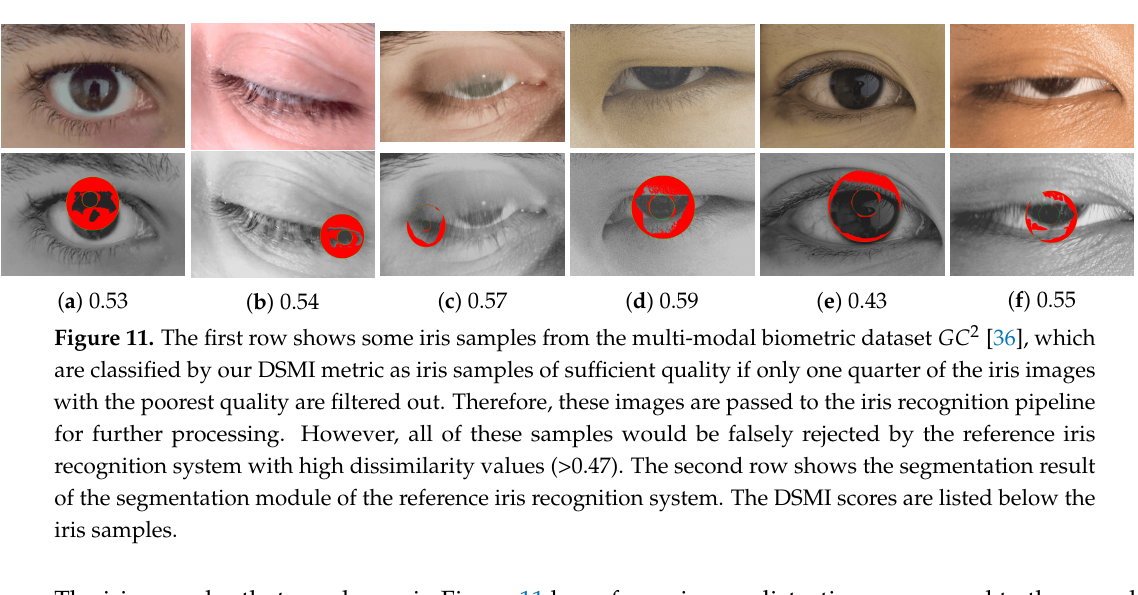
Figure 10. The first row shows some iris samples from the multi-modal biometric dataset GC 2 [36], which are classified as low-quality samples by our DSMI metric. All of these samples would be falsely rejected with high dissimilarity scores (>0.47) by the reference iris detection system. However, if we filter out a quarter of the iris images with the poorest quality from each test dataset, these samples will be removed and not passed to the iris recognition system. The second row shows the segmentation result of the segmentation module of the reference iris recognition system. The DSMI scores are listed below the iris samples.